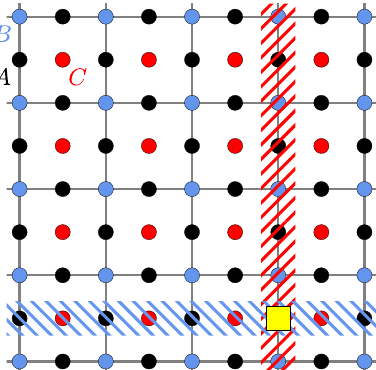
FIG. 8. Lattice of spins used in the construction of a minimal Hamiltonian displaying the quasiperiodic symmetry-protected topological phase introduced in Sec. V B 1. Spins are placed on the links ( A , black), vertices ( B , blue), and plaquettes ( C , red) of a 2D square lattice. The ground state is a superposition of fluctuating domain walls of Ising orders of the B spins (blue hatched region) and C spins (red hatched region). In the topological phase, the intersection of these domain wall (yellow square) binds an Ising charge of A